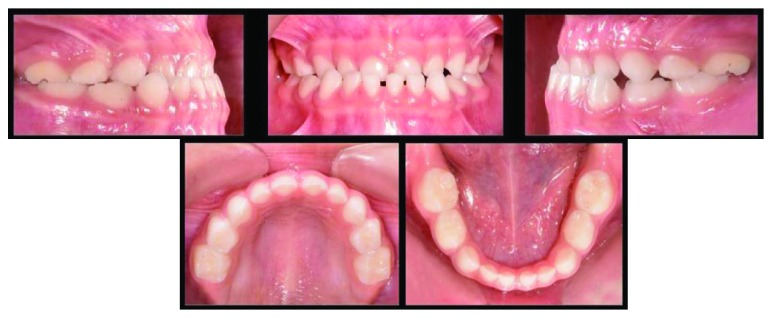
Intraoral findings.